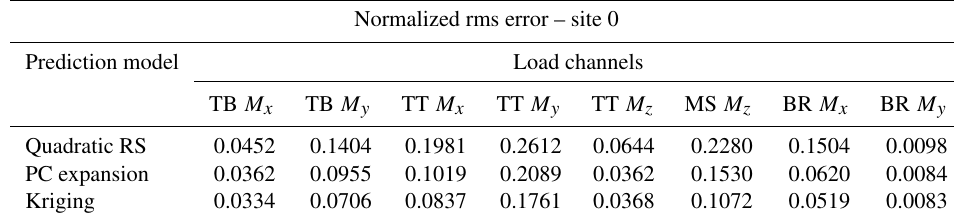
Table 2. Normalized root mean square error characterizing the difference between aeroelastic simulations and reduced-order models. Load channel abbreviations are the following: TB: tower base; TT: tower top; MS: main shaft; BR: blade root. Loading directions consist of M x : fore-aft (flapwise) bending, M y : side-side (edgewise) bending, and M z : torsion.